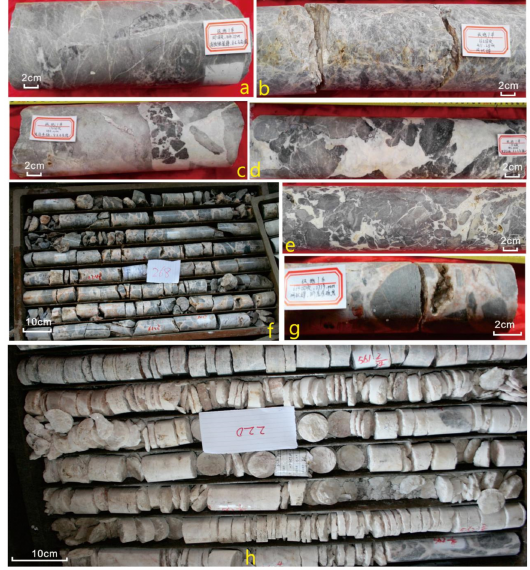
Figure 3. Dissolution morphology related to fractures in deep karst space of wells HD1-4. ( a ) Micro network cracking, 464 m; ( b ) Micro network cracking, 415 m; ( c – e ) Further dissolution of structural breccias and cracks, improving the gravel roundness, and dissolved cracks and holes filled with white dolomite, 444–448 m; ( f , g ) Structural network cracking zone, semi-fully filled by white calcite and tending to maculosus in 1718–1721 m; ( h ) Structural calcite vein, 6 m long and developing in fault core, 1454–1460 m.